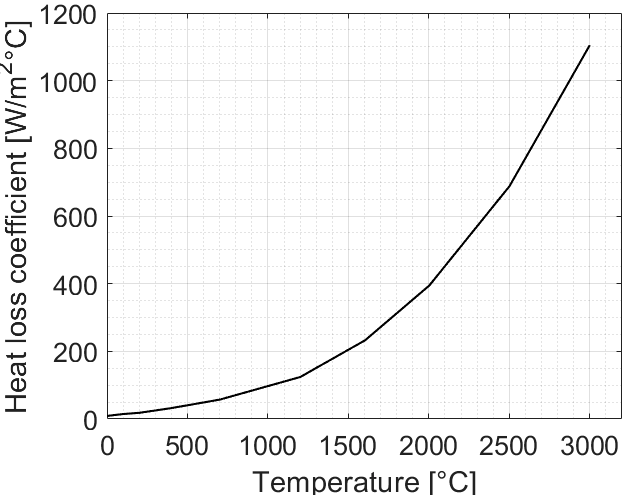
Figure 7. Heat loss convective and radiative coefficient.